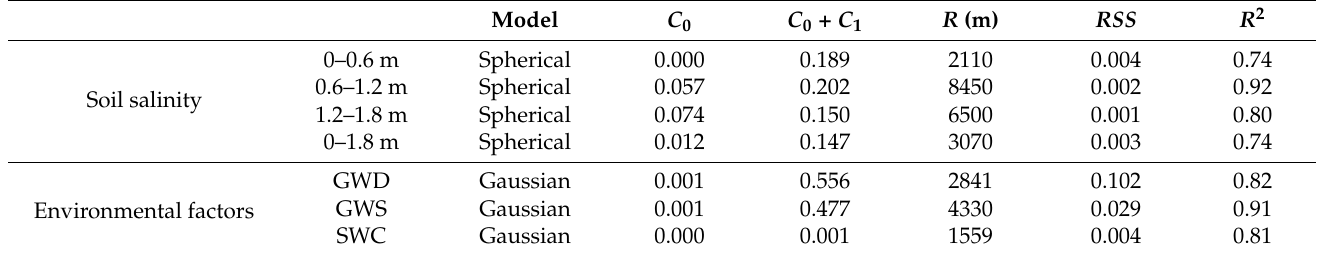
Table 2. The semivariogram models of soil salinity and environmental factors.